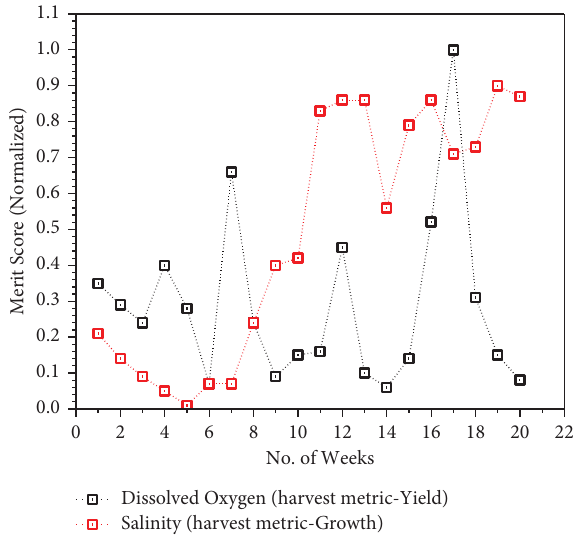
Figure 7: Impact of dissolved oxygen and salinity when harvest metrics are taken as yield and growth, respectively.